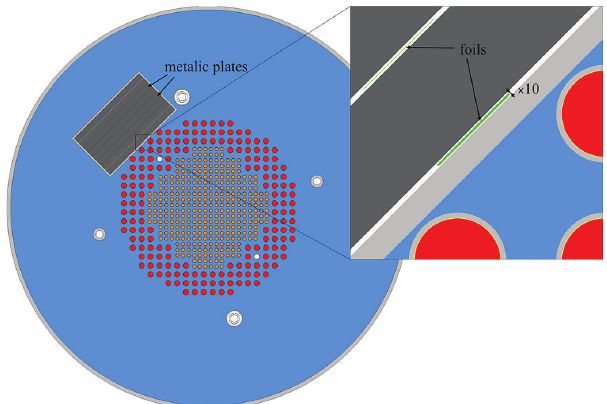
Fig. 3. Axial CROCUS geometry represented using the Serpent2 code, with addition of the PETALE metal reflector. The oxide uranium fuel is displayed in orange, the metallic uranium fuel in red, and the water in blue. The four circles out of the metallic fuel zone are the reactor monitors, namely fission and ionisation chambers, and the PETALE experiment is the grey element at the North-West (top-left) of the reactor. A zoom on the interface between CROCUS and PETALE shows the first foil with a width multiplied by 10 in order to be visible (1g of indium for the first foil instead of